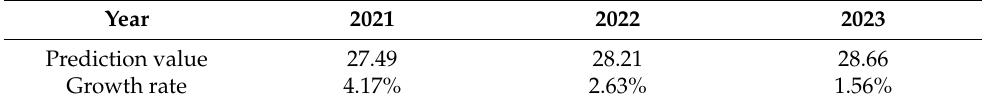
Table 2. The prediction values of TOVCI of China (Trillion